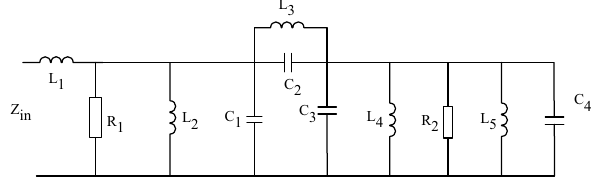
FIGURE 4. Equivalent